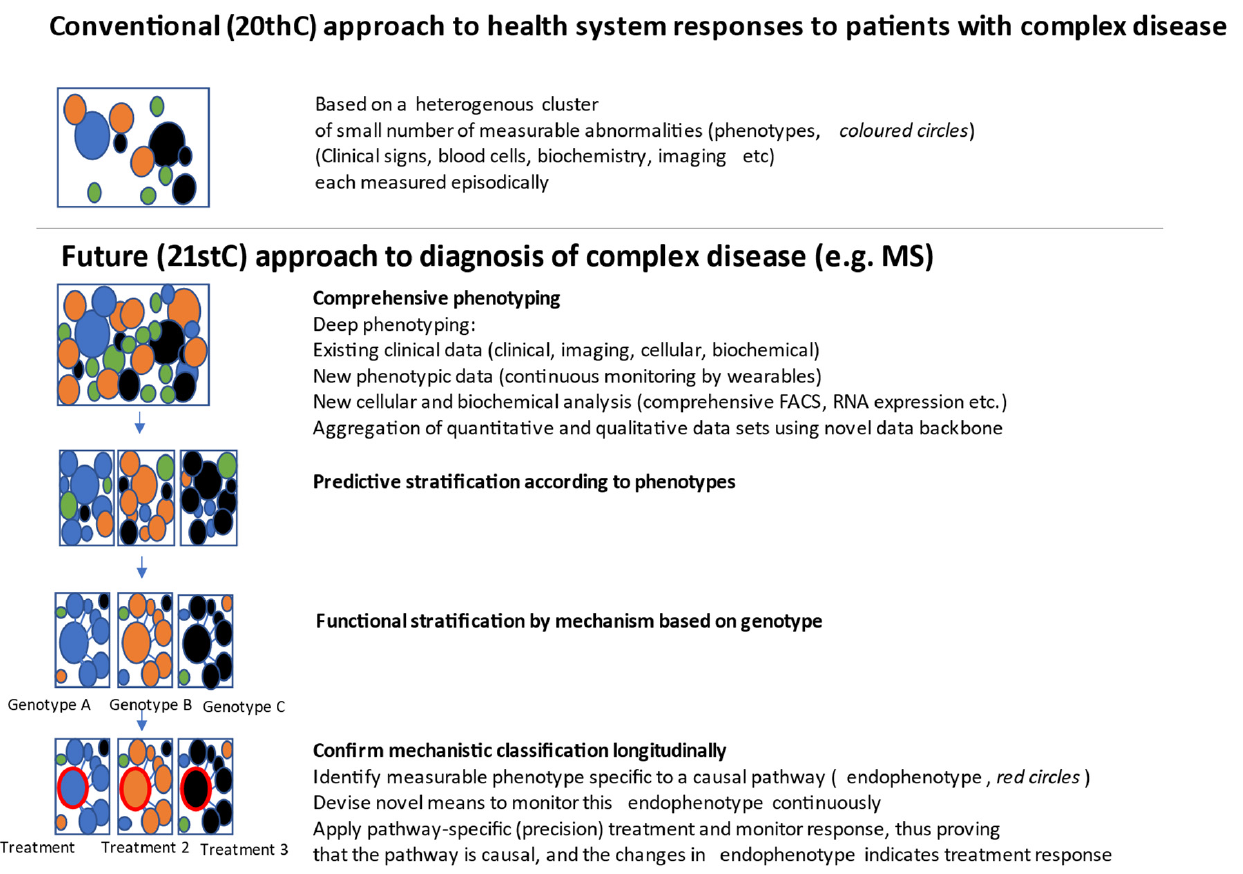
Figure 1. How personalized medicine will change the understanding and treatment of complex conditions such as MS.